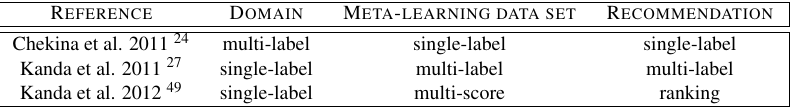
Table 1: Classification of meta-learning and multi-label learning proposals according to the type of domain used in each stage of